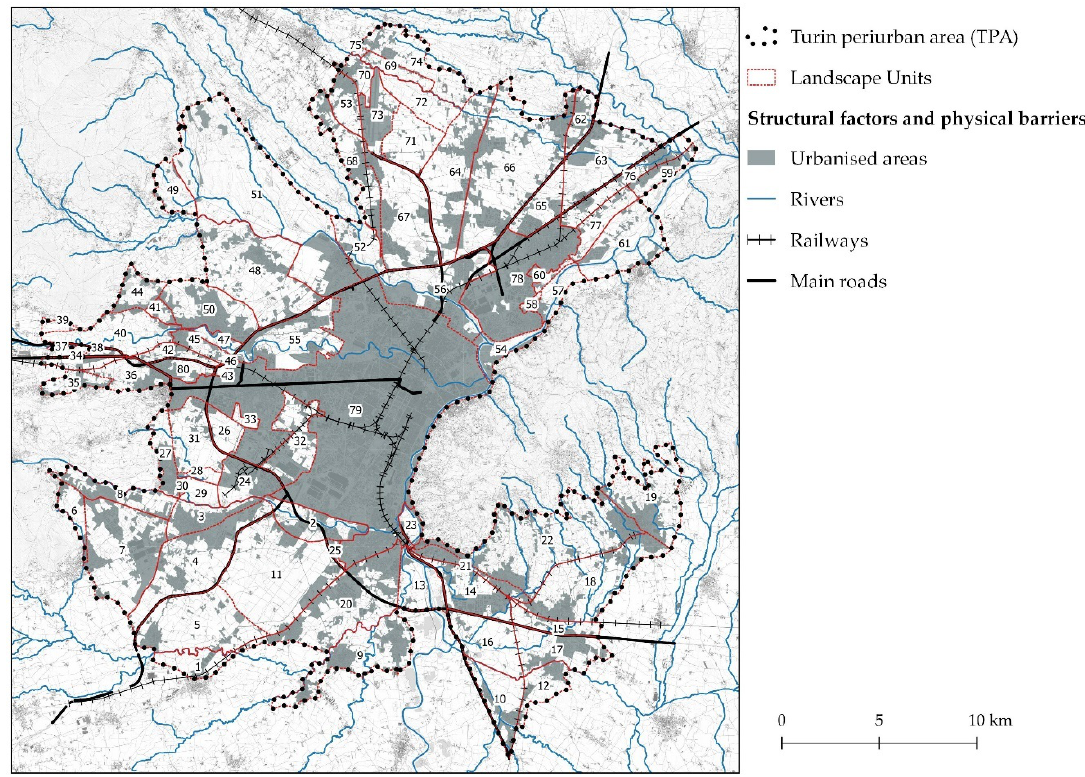
Figure 4. Map of the peri-urban landscape units.